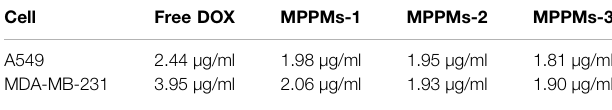
Frontiers in Pharmacology |